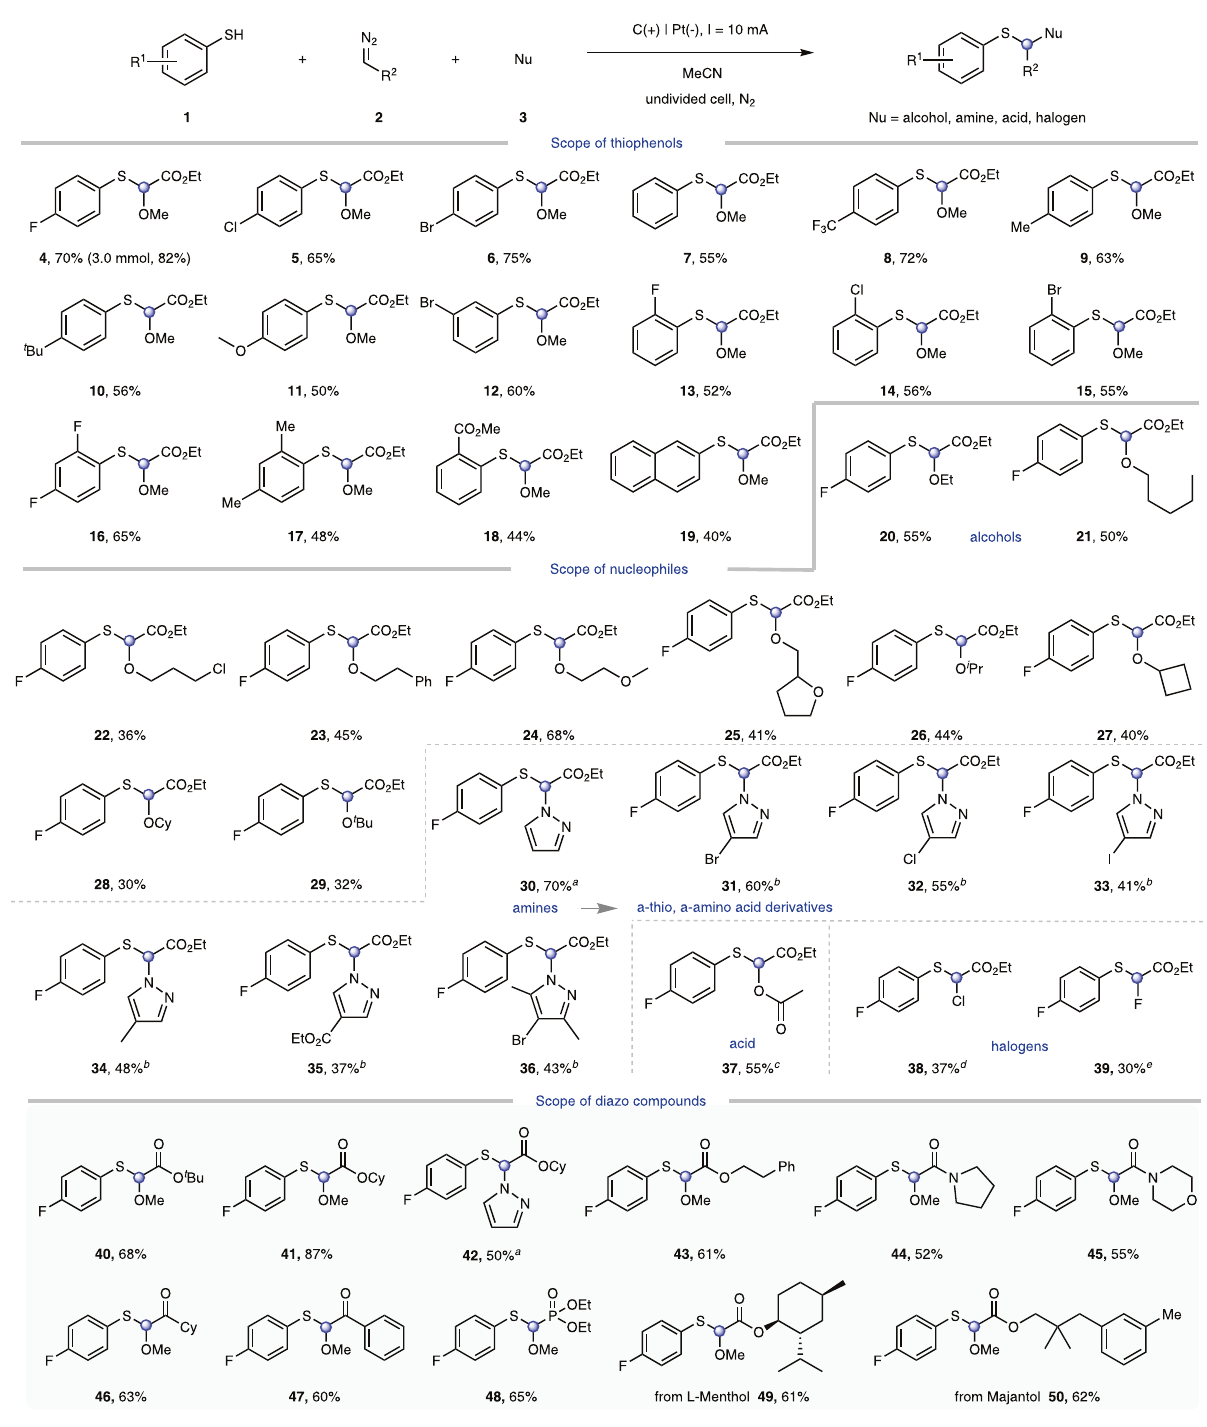
Fig. 2 | Scope of thiophenols, nucleophiles and diazo compounds. Standard conditions: thiolating agents (0.5mmol), diazo compounds (2.0mmol), alcohols (0.5mL), Et 4 NBF 4 (0.5mmol), MeCN (6mL), carbon rod as anode, platinum as cathode,undividedcell,constantcurrent=10mA,50 o C,N 2 ,5h,yieldisthatofthe isolated product. a Used pyrazole (2.0mmol) instead of alcohol. b Used pyrazole